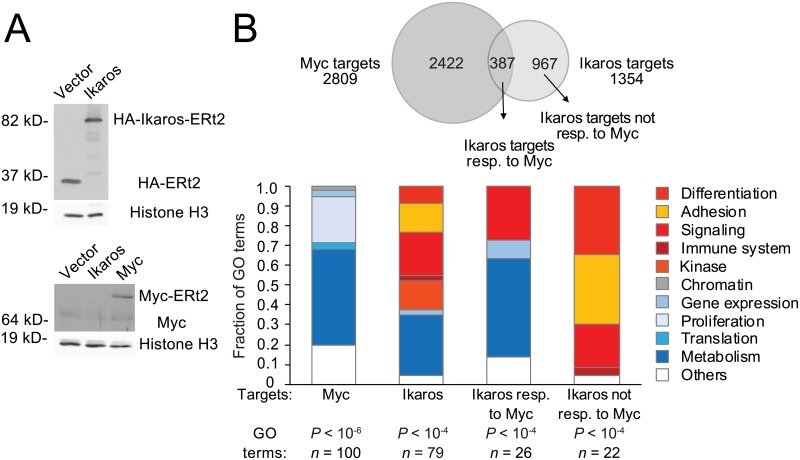
Inducible expression of Myc defines Myc-responsive and Myc-unresponesive Ikaros target genes.(A) Expression of Ikaros-ERt2 and Myc-ERt2 in B3 cells as detected by western blotting. (B) Chromatin RNA-seq showed that the expression of 2,809 genes was regulated by Myc (adj. P < 0.05) and the expression of 1,978 genes was regulated by Ikaros (adj. P < 0.05) in B3 cells. Of these, 587 genes were responsive to Myc and also to Ikaros (top). GO analysis of the biological function of Myc- and Ikaros-regulated genes, and of Ikaros-regulated genes that are also regulated by Myc (Myc-responsive) or not regulated by Myc (not Myc responsive, bottom). The top GO terms are shown; numbers and P values are indicated. The source of the numerical data underlying this figure is listed in S1 Data. ERt2, mutant estrogen receptor; GO, gene ontology; HA, haemagglutinin; Myc, MYC proto-oncogene; RNA-seq, RNA sequencing.